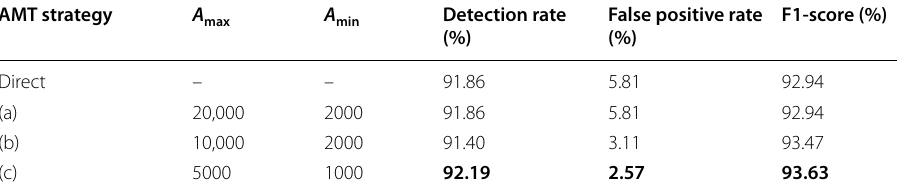
, A } for the dLSTM refiner max min False positive rate F1‑score (%) (%) (%)